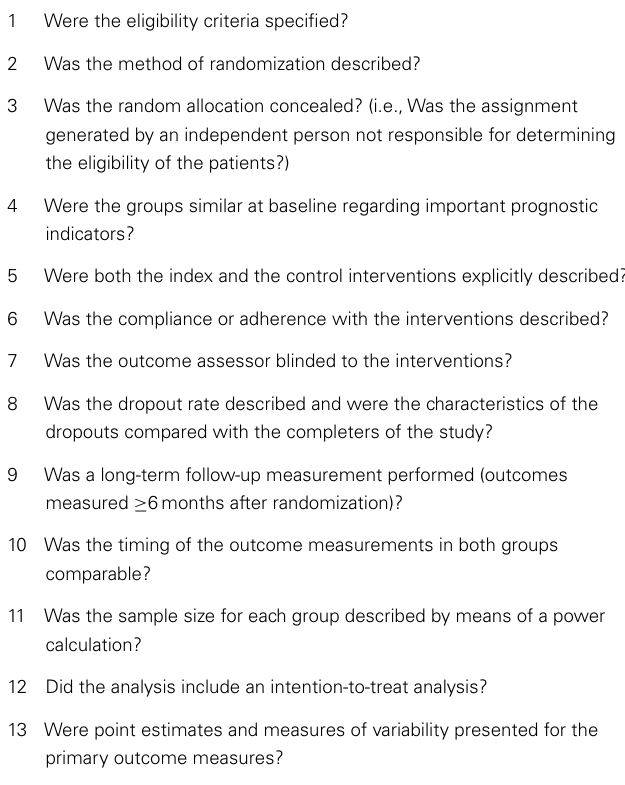
Table 2 | Criteria of methodological quality